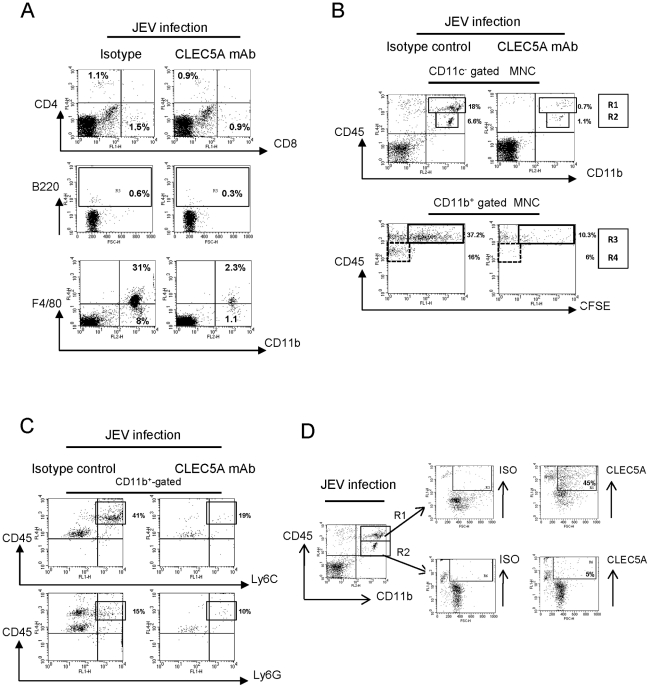
Effect of anti-CLEC5A mAb on recruitment of immune cells into the CNS during JEV-infection.(A) Flow cytometry analysis of mononuclear cells (MNCs) isolated from JEV-infected murine brain tissue with isotype control or anti-CLEC5A mAb treatment at day 5 post infection; cell populations were determined by staining specific cell surface markers. (B) MNCs were further characterized by determining expression levels of CD45 in the CD11b+CD11c− population to distinguish inflammatory myeloid cells from peripheral (R1, CD45hi) and resident microglia (R2, CD45low), respectively (upper panel). Recruitment of CD11b+CD45+ cells into brain of JEV-infected mice was tracked by in vivo labeling of blood cells with fluorescent dye CFSE. (C) Analysis of the CD45+CD11b+ population for Ly6C and Ly6G expression revealed the major Ly6C+ and minor Ly6G+ populations in CD11b+CD45hi peripheral inflammatory myeloid cells. The percentages indicate the specific region in CD11b+-gated cells (the collected CD11b+ cells in the isotype group and CLEC5A mAb treatment group are approximately 25,000 cells and 1,000 cells, respectively.) Three independent experiments with three mice per group were performed and representative FACS plots are shown. (D) CLEC5A expression in peripheral inflammatory myeloid cells (R1-gated; CD11c−CD11b+CD45hi) and residential microglia (R2-gated; CD11c−CD11b+CD45low) isolated from JEV-infected murine brain.